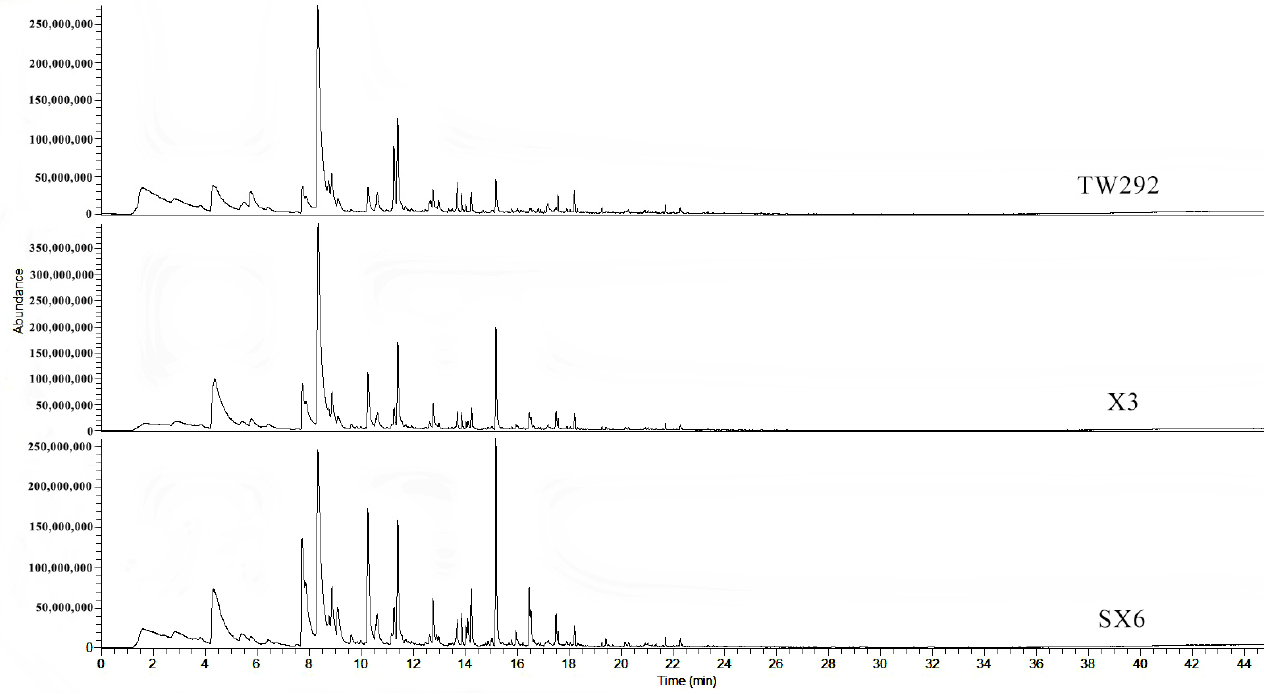
Figure 4. Total ion chromatogram of volatile compounds of vegetable soybeans. Table 3. Relative content of volatile compounds among different classes in vegetable soybean